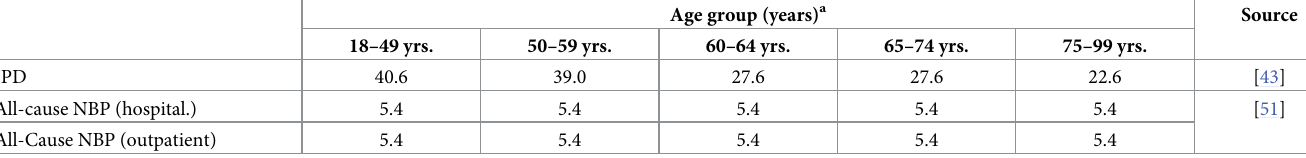
Table 3. Maximum herd effect in year 5 of modelling (absolute in